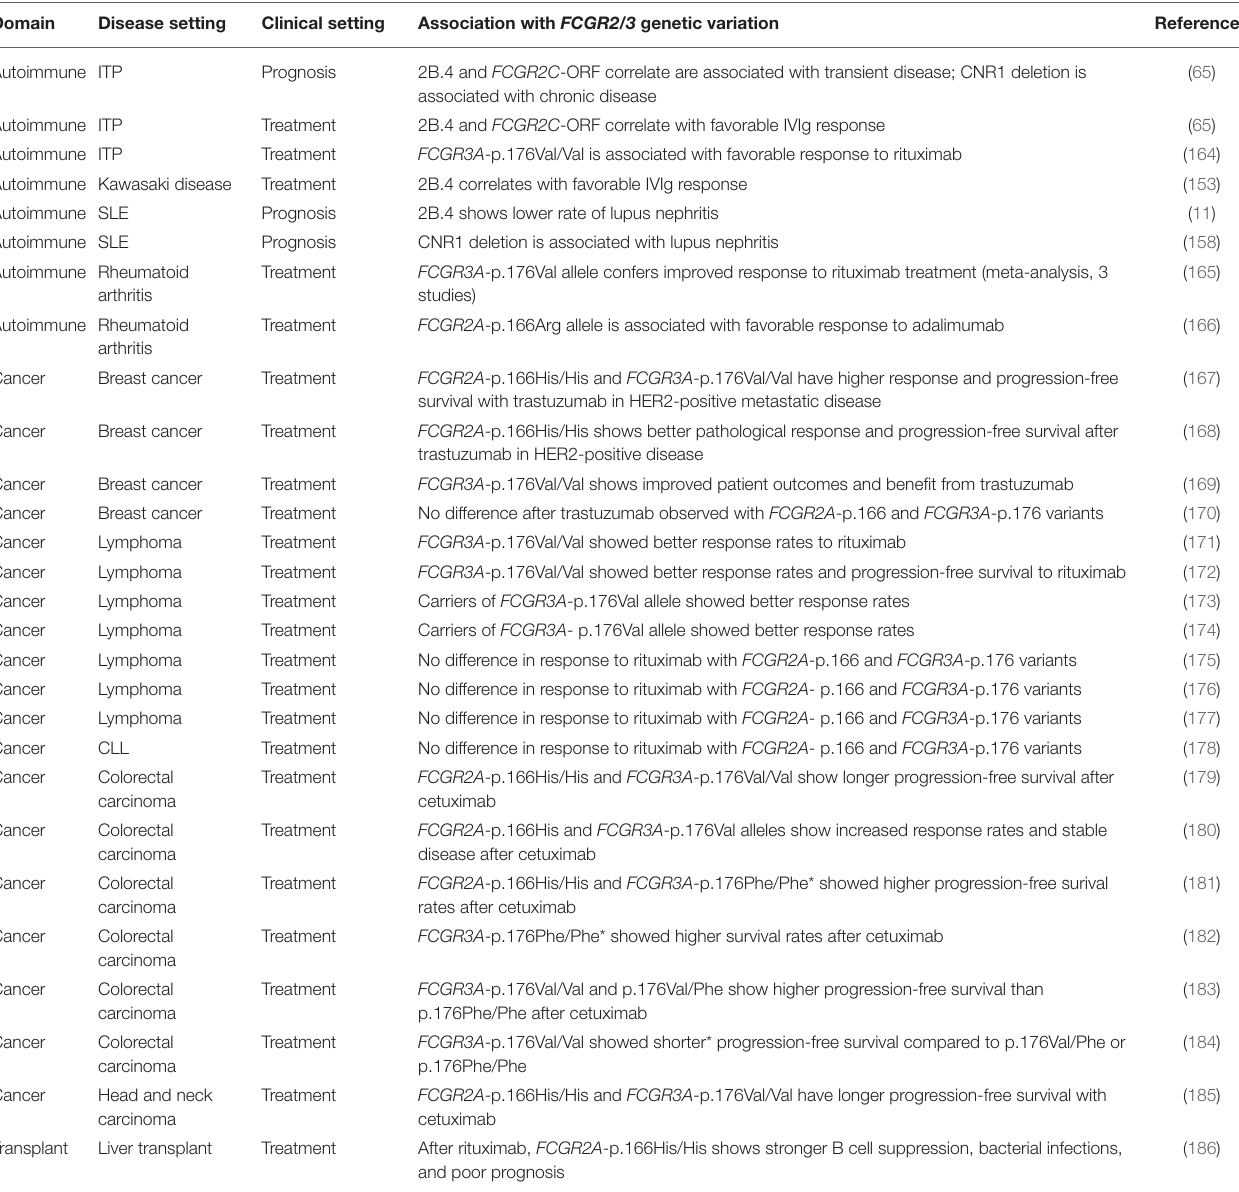
TABLE 3 | Opportunities to use FCGR2/3 locus genotyping in personalized medicine: polymorphisms and copy number variation.